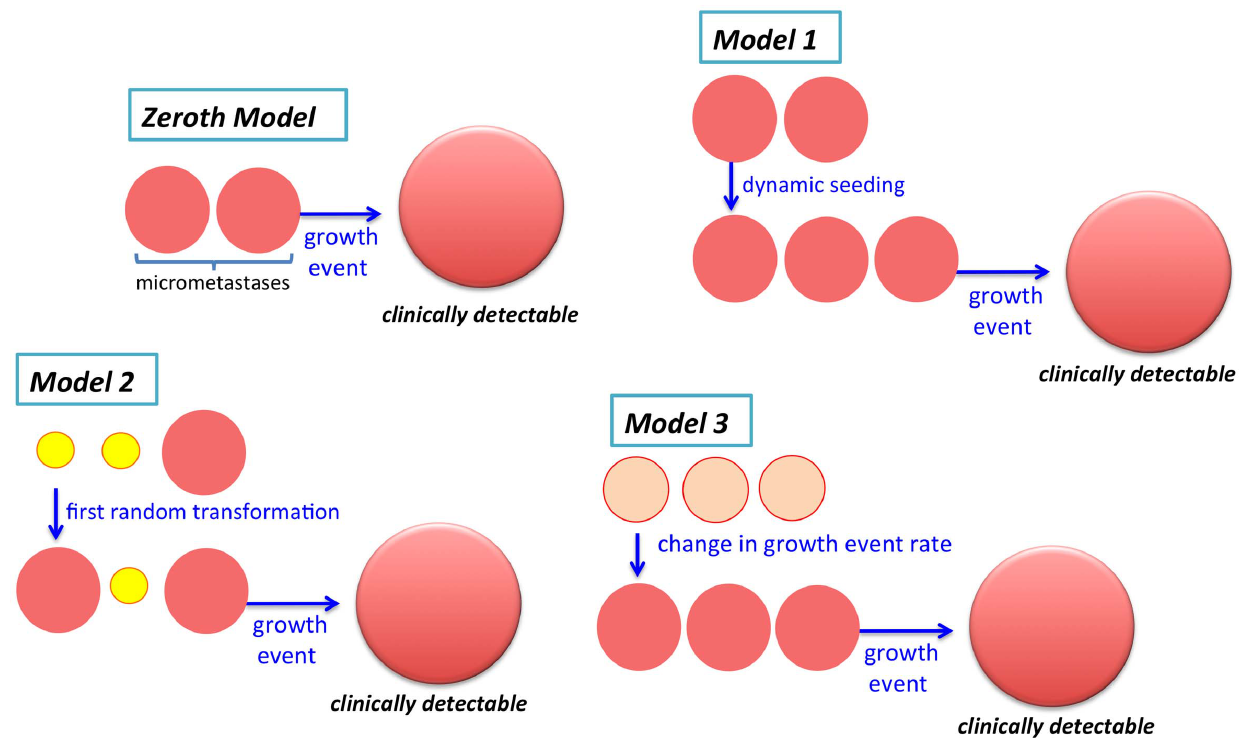
Figure 1. Models. The four models describe four different scenarios for how a patient, who at the time of resection has no detectable or growing cancers, progresses between the states of dormancy, clearance, growth, and relapse.